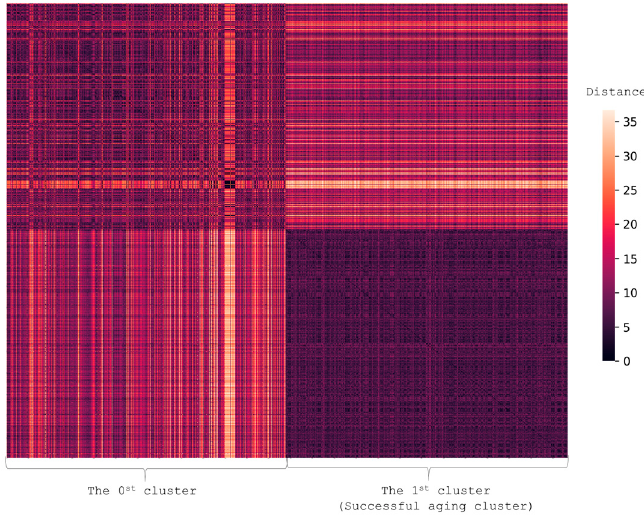
Figure 4. Heatmap illustrating the difference in the presence of AADs and GSs. Each person is represented by a vector with values showing the presence of AADs (cancer, CVD, DM2, and COPD) and scores on MMSE, FAB, and SPPB. The figure shows the pairwise distance matrix for the selected set of individuals in Euclidean space. The X-axis is selected set of individuals and the Y-axis is the same set (the matrix is symmetric). The lighter the pixels, the bigger the difference between the pair in terms of selected features. The heatmap shows that the successful aging cluster (Cluster 1) differed from Cluster